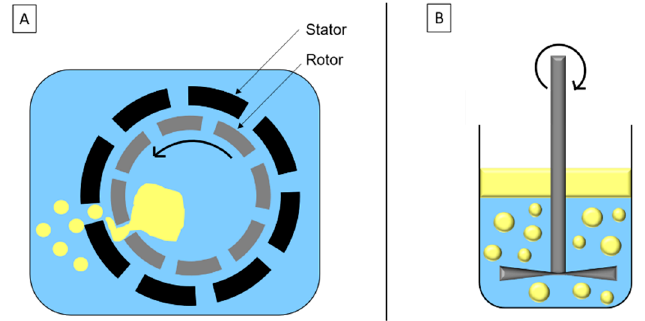
Figure 2. Schematic representation of ( A ) high ‐ speed homogenization and ( B ) disc system. Low-Frequency Ultrasounds